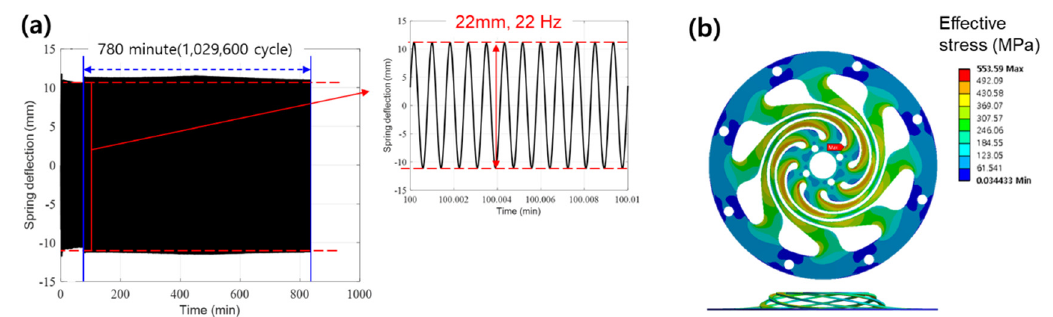
Figure 19. ( a ) Fatigue test measured at 11 mm spring displacement and ( b ) structural stress analysis at 11 mm displacement.